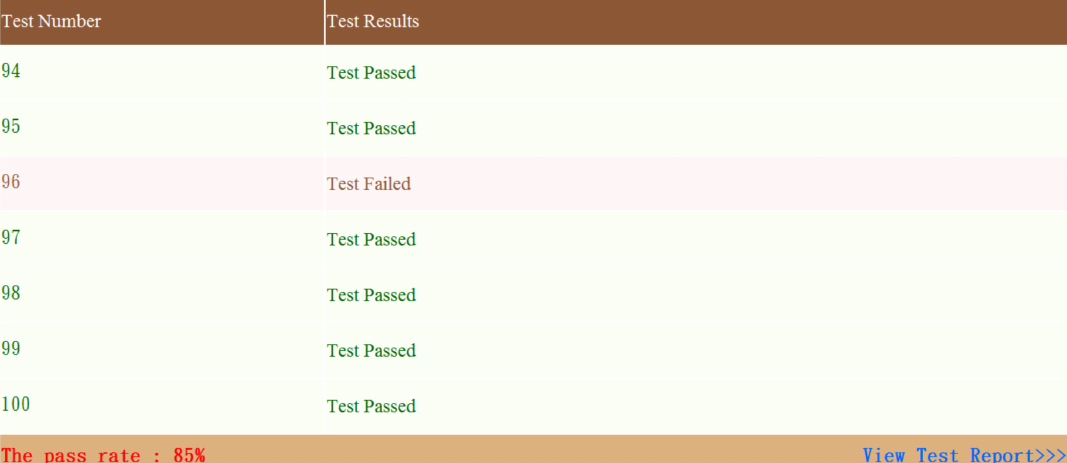
Figure 29. Test result